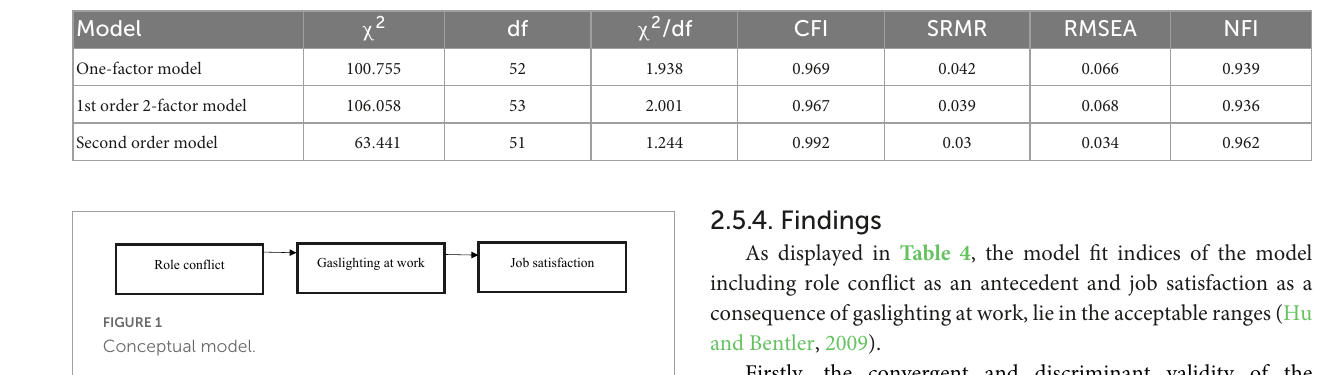
TABLE 3 Model fit indices of competing models.